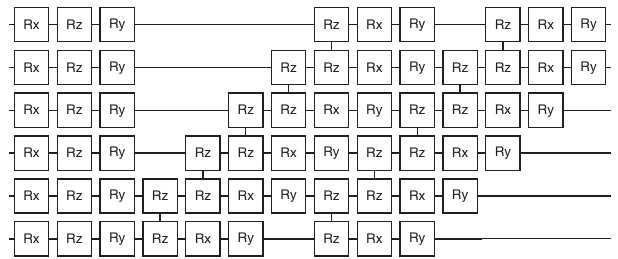
FIG. 11. One layer of the hardware-efficient Ansatz used in numerics for six